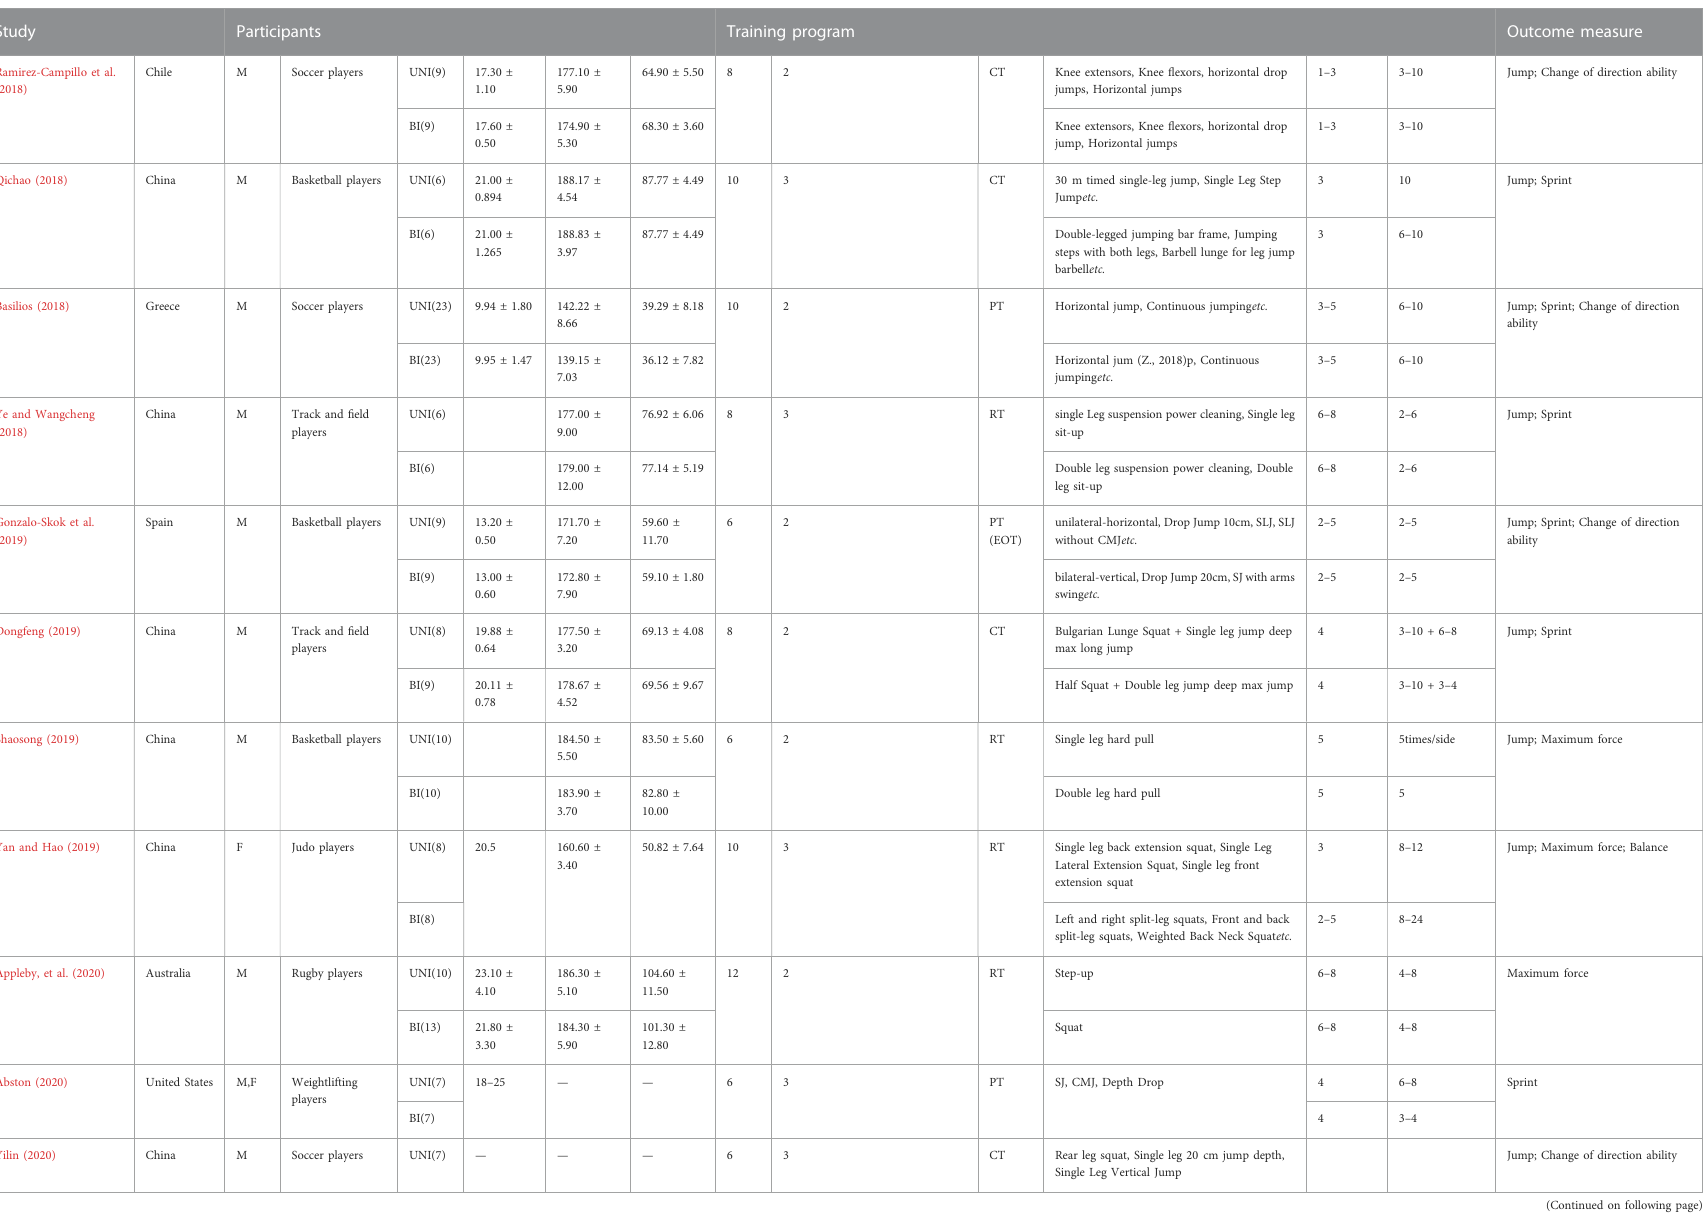
TABLE 2 ( Continued ) List of basic characteristics of the included literature Abbreviations: M = male; F = female; RT = Resistance training; PT = Plyometric training; CT = complex training; EOT = Eccentric-overload training.